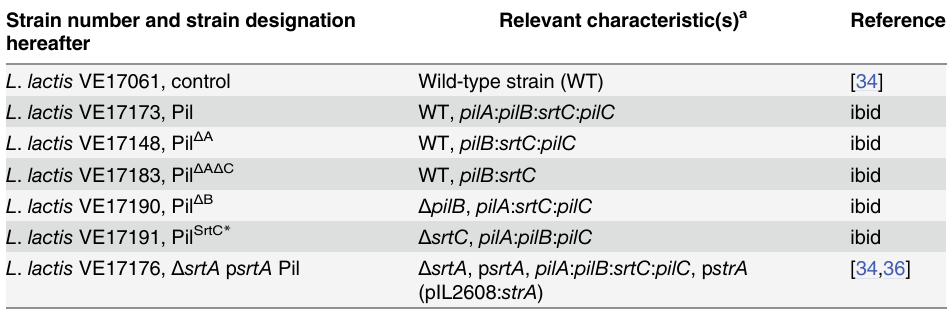
Table 1. Bacterial strains and plasmids used in this study.